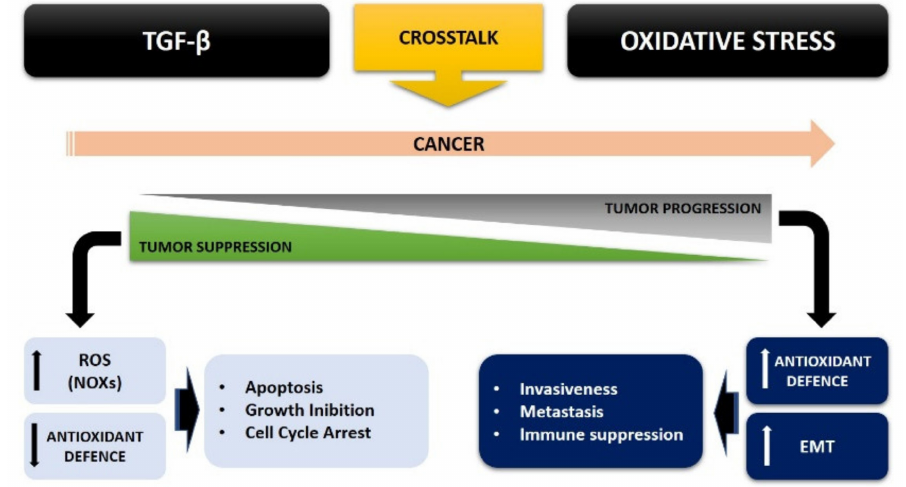
Figure 2. TGF- β and oxidative stress crosstalk in cancer